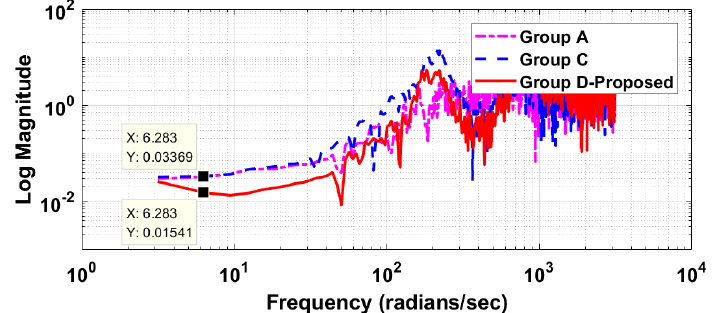
Figure 16. Frequency isolation